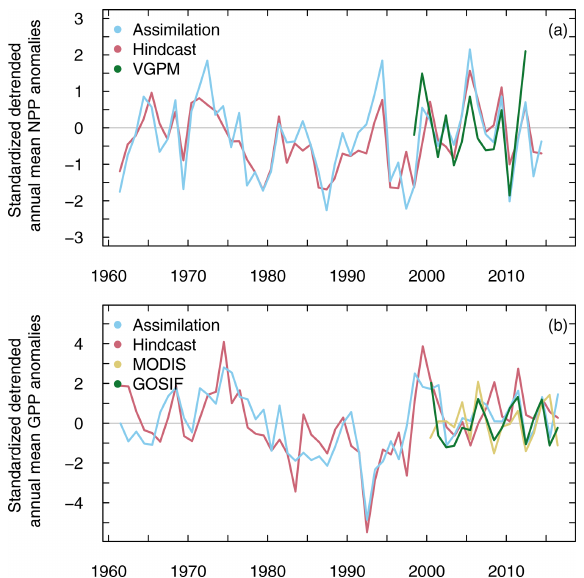
Figure 21. (a) Ocean-integrated net primary productivity in the Ca- nary Current region (25–34 ◦ N, 10–18 ◦ W), and (b) gross primary productivity on the global land, for the assimilation runs (blue) and Year 1 hindcasts (red). Observation-based estimates for (a) ocean, the Vertically Generalized Production Model (VGPM) (green), and (b) land, MODIS (yellow), and Orbiting Carbon Observatory-2 (OCO-2)-based solar-induced chlorophyll fluorescence (SIF) prod- uct (GOSIF) (green) are described in Appendix B. Anomalies rel- ative to the base period (2000–2016) have been linearly detrended and